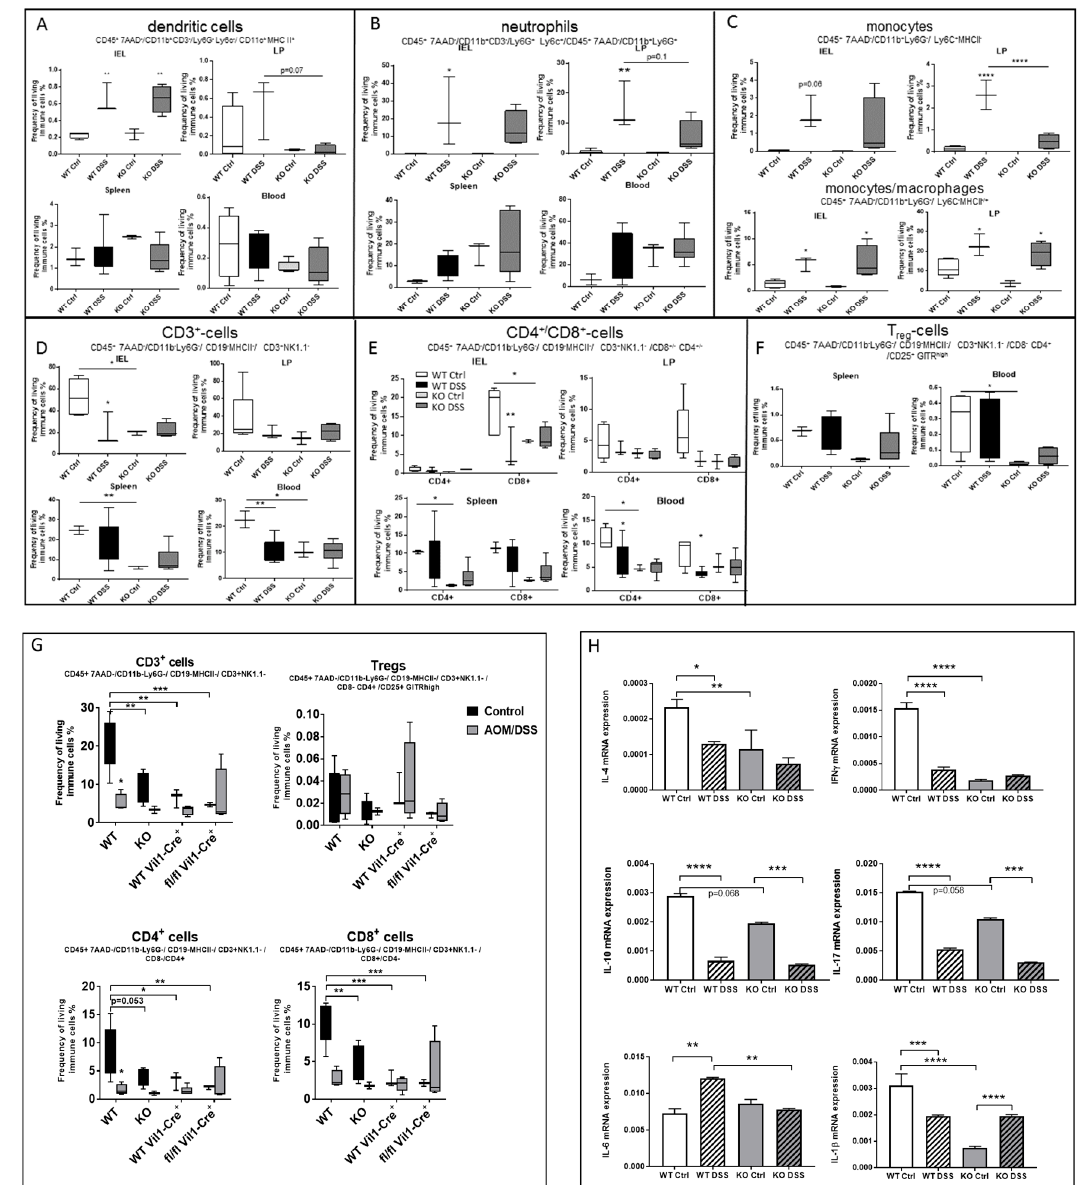
Figure 5. Flow cytometry analysis of different mice tissues (intraepithelial lymphocytes (IEL), lamina propria (LP), spleen, and blood) upon acute DSS treatment in CerS5-wt and -ko mice. Dendritic cells ( A ), neutrophils ( B ), and monocytes / macrophages ( C ) were increased in the colon tissue fractions after DSS treatment. By contrast, CD3 + T-cells were decreased in CerS5-wt mice after DSS treatment or were already low in CerS5 ‐ ko mice (control and DSS ‐ treated) ( D–F ). Shown are mean ± min/max IEL: WT Ctrl n = 5, WT DSS n = 3, KO Ctrl n = 3, KO DSS n = 4; LP: WT Ctrl n = 5, WT DSS n = 3, KO Ctrl n = 2, KO DSS n = 4; spleen: WT Ctrl n = 3, WT DSS n = 6, KO Ctrl n = 3, KO DSS 6; blood: WT Ctrl n = 3, WT DSS n = 7, KO Ctrl n = 3, KO DSS n = 6. ( G ) Blood T ‐ cell status in CerS5 ‐ wt and CerS5 ‐ ko